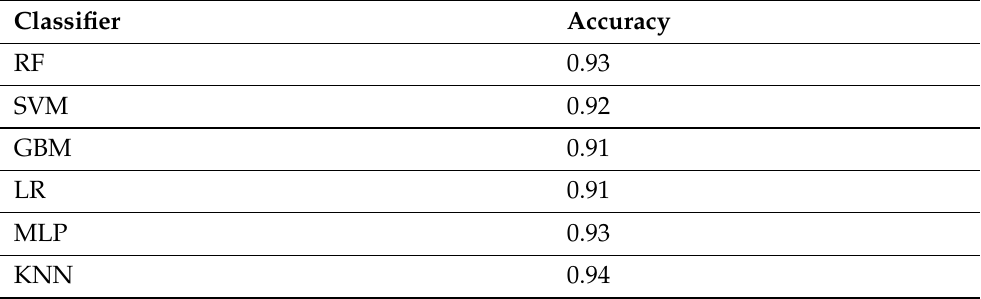
Table 5. Classification results using all 30 features from the